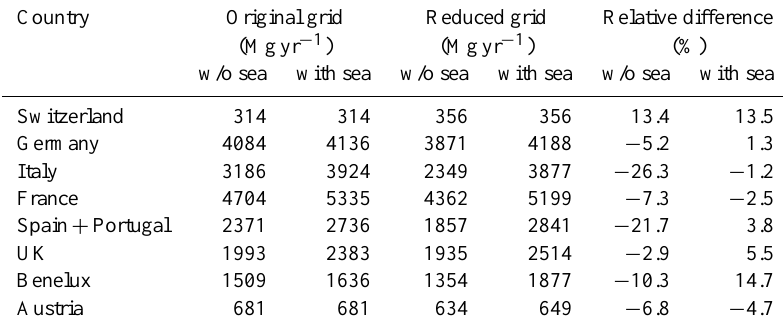
Table 1. Country emissions and aggregation errors introduced by reduced grid. For columns denoted “with sea” the sea fractions of pixels partially over sea and over land are attributed to the surrounding countries proportional to their relative areal share. Country Original grid Reduced grid Relative difference (Mgyr − 1 ) (Mgyr − 1 ) (%) w/o sea with sea w/o sea with sea w/o sea with sea Switzerland 314 314 356 356 4084 4136